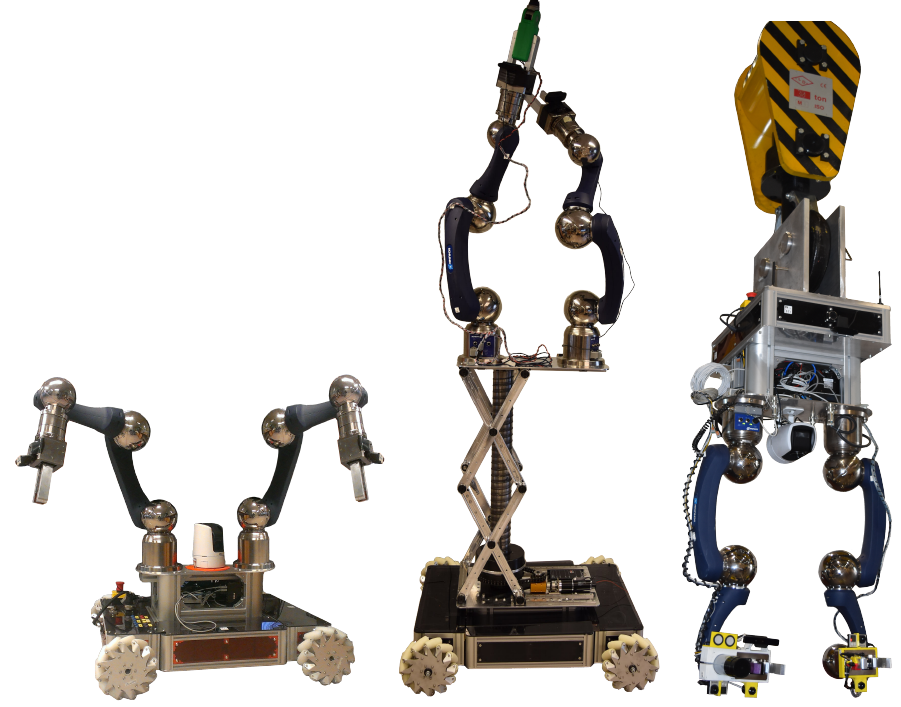
Figure 5. CERNTAURO Project dual-arm robot